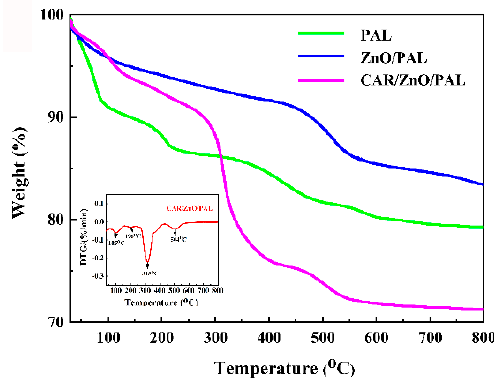
Figure 4. TG curves of PAL, ZnO/PAL, and CAR/ZnO/PAL.